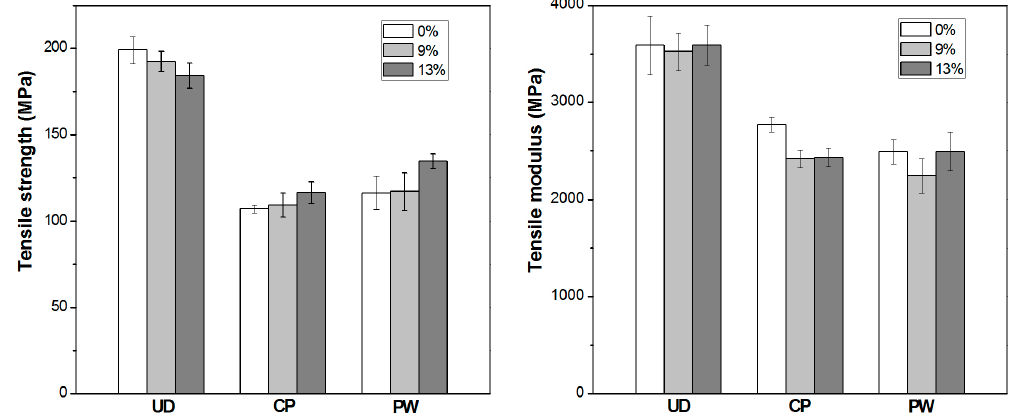
Figure 1. Tensile strength and modulus of additive-free and flame retarded PP SRCs with UD, CP and PW reinforcement.